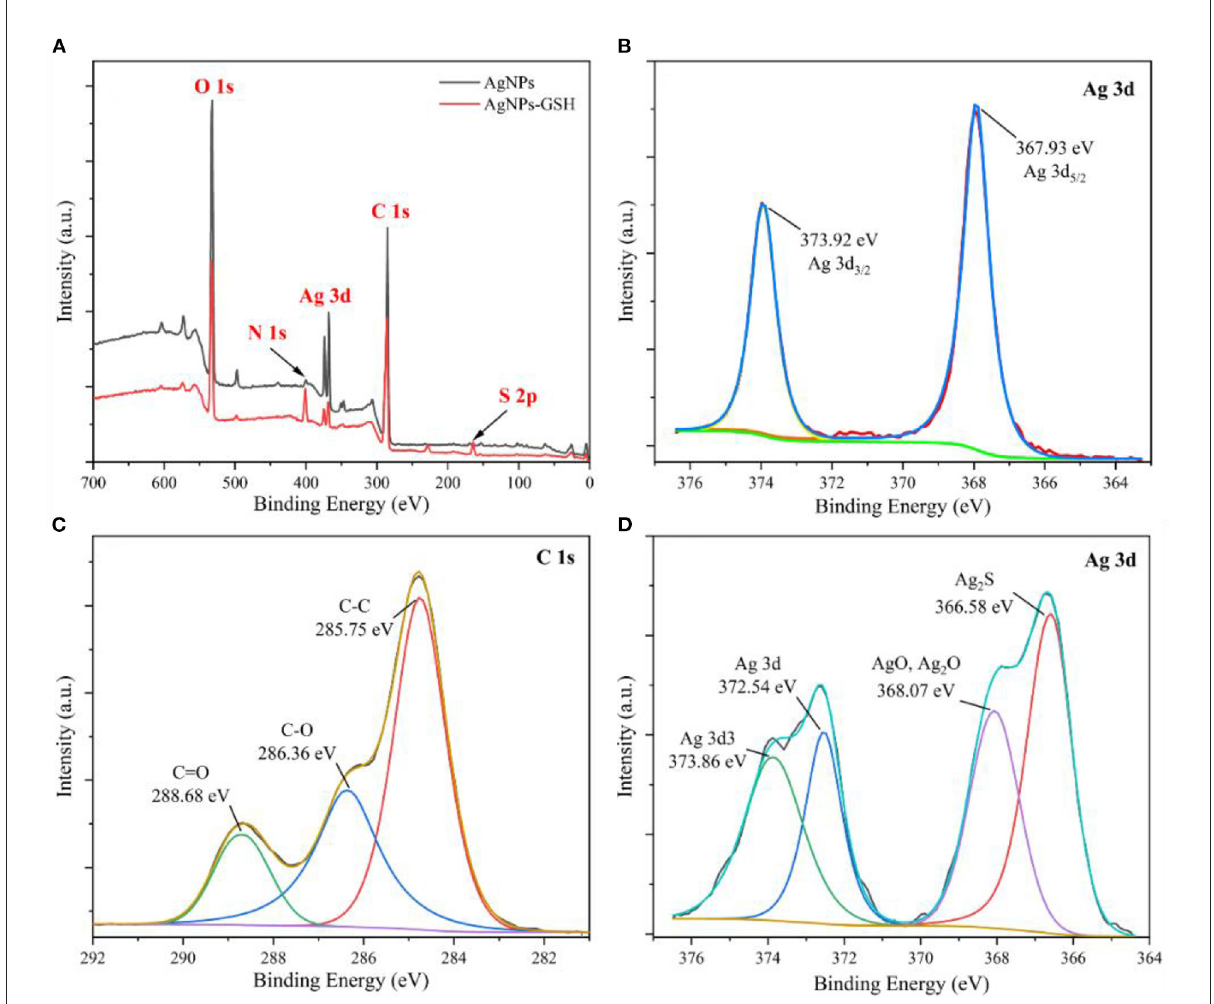
FIGURE3 XPS full spectra of AgNPs (A) , Ag 3d spectrum (B) , C 1s spectrum (C) , Ag 3d spectrum with 0.03 mg/mL GSH AgNPs addition (D)